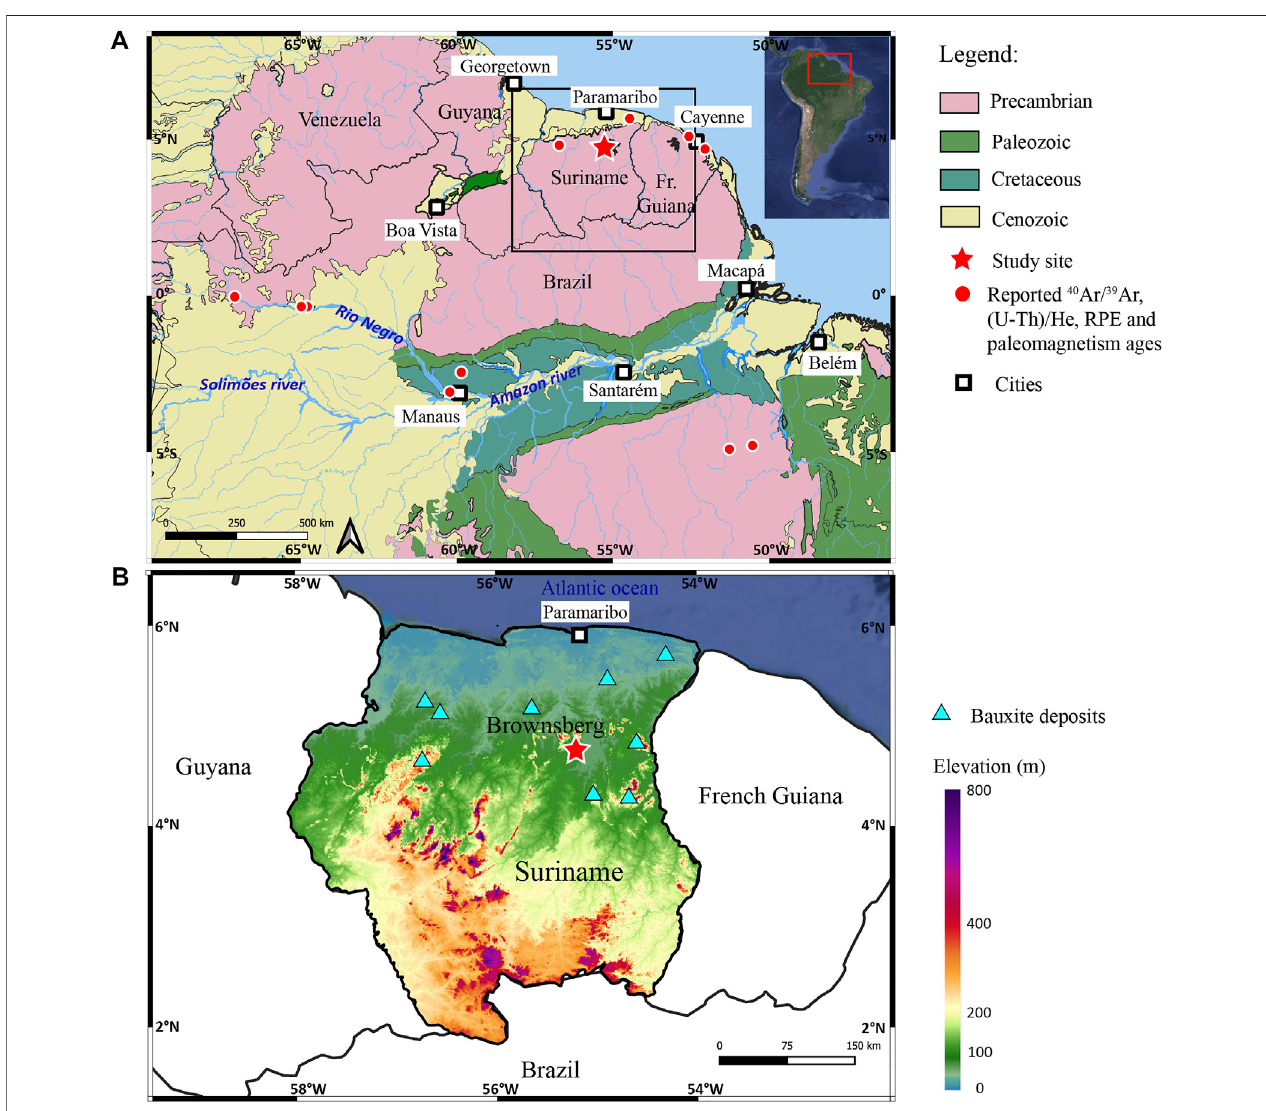
FIGURE 1 | (A) Simpli fi ed geological map of the Guiana shield (data from geosgb. cprm.gov.br) with location of dated laterites with 40Ar/39Ar, (U-Th)/He, EPR, or paleomagnetism on the Amazon craton (Vasconcelos et al., 1994; Théveniaut and Freyssinet, 2002; Balan et al., 2005; Allard et al., 2018; Heller et al., 2022) and (B) elevation map with known bauxite deposits in